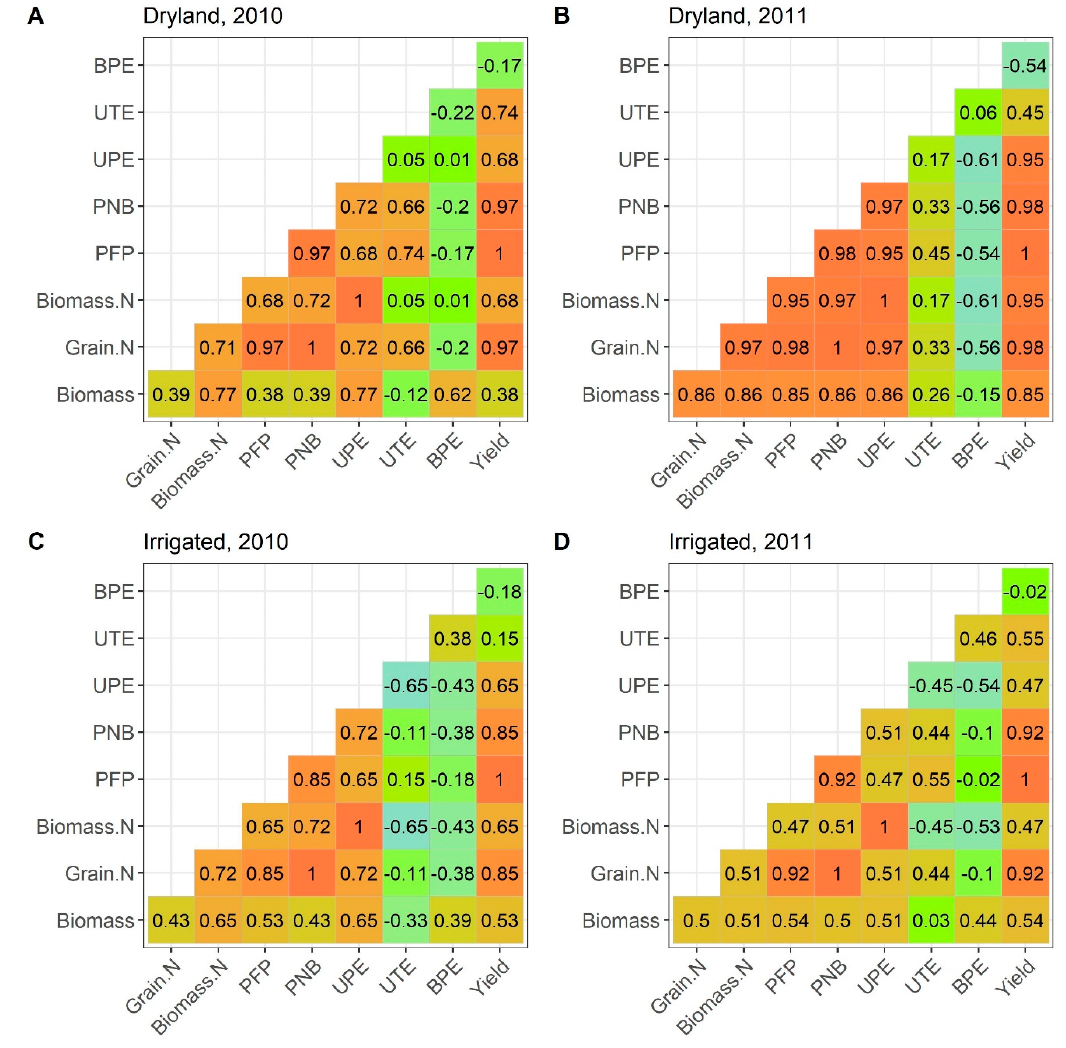
Figure 4. Correlation coefficients (r) between parameters of interest for ( A ) dryland, 2010; ( B ) dryland, 2011; ( C ) irrigated , 2010; and ( D ) irrigated conditions, 2011, across 24 wheat genotypes. Blue, green and red colors indicate negative, low and positive correlations, respectively. Biomass = total plant biomass; Grain.N = Nitrogen content in grain; Biomass.N = Nitrogen content in plant biomass; PFP = Partial factor productivity; PNB = Partial nitrogen balance; UPE = Uptake efficiency; UTE = Utilization efficiency; BPE = Biomass production efficiency.